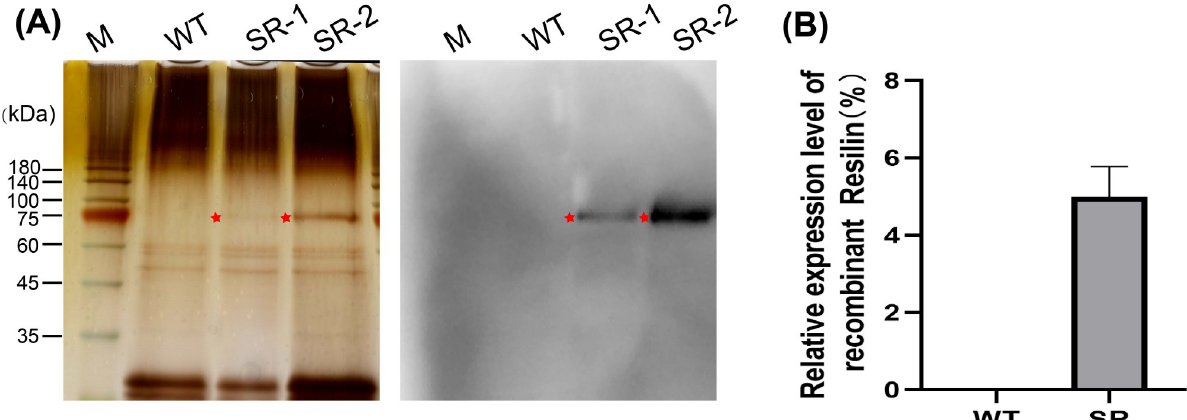
Fig 3. Expression identification and analysis of the recombinant resilin in the silkworm cocoon shells. (A) The recombinant resilin in cocoon shell were detected by silver staining (left) and Western-blot (right). WT: the wild-type silkworm Lan10. SR-1 and SR-2: different individuals of the transgene-positive silkworm germ line. (B) Expression analysis of the foreign protein relative to the FL protein through gray analysis using the Gel- Pro-analyzer4 software. WT: the wild-type silkworm Lan10. SR: the transgene-positive silkworm germ line. The target protein band is marked by an asterisk.